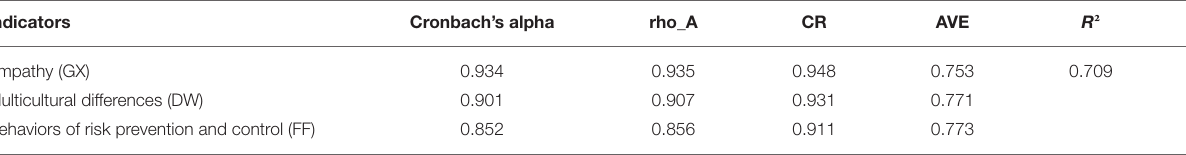
TABLE 4 | Model reliability test results and fit indices.